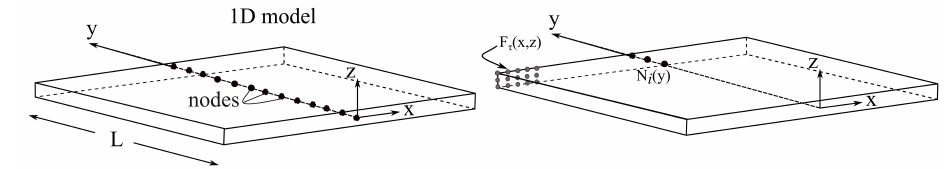
Figure 1. The modeling of a beam structure using a 1D model where y is the along the beam axis, and the cross-section lies on the x – z plane through thickness.